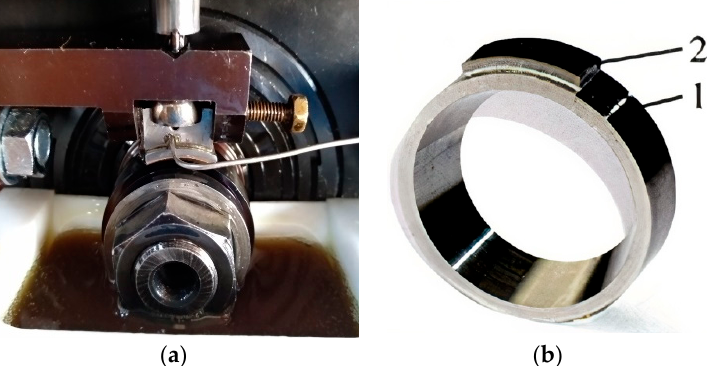
Figure 3. The friction pair in block on ring tester ( a ) and composition of friction pair: 1—ring specimen, 2—counterpart ( b ).